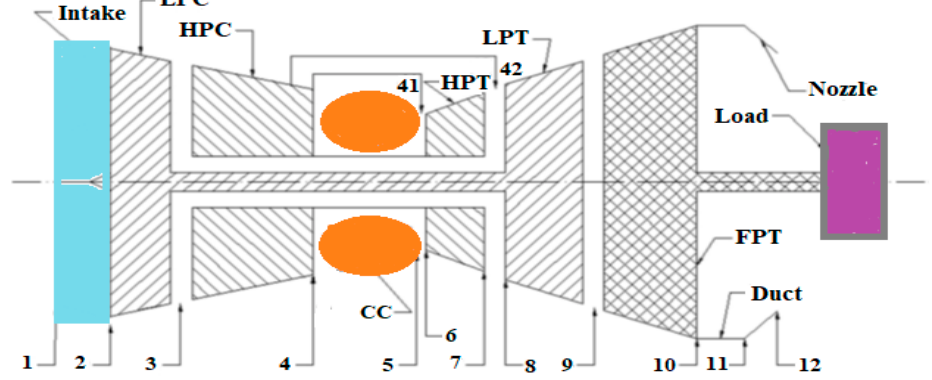
Figure 1. Three-shaft gas turbine configuration .